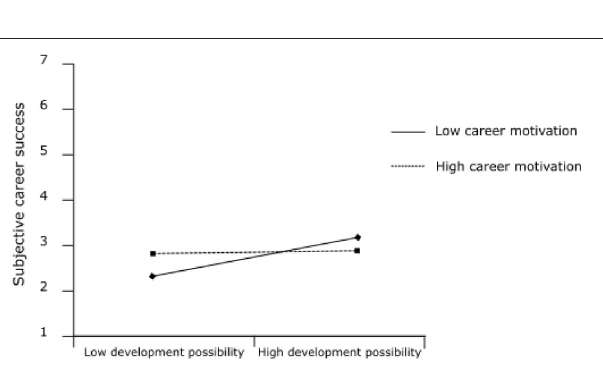
FIGURE 2 | The interaction of career motivation and development possibilities in predicting subjective career success.